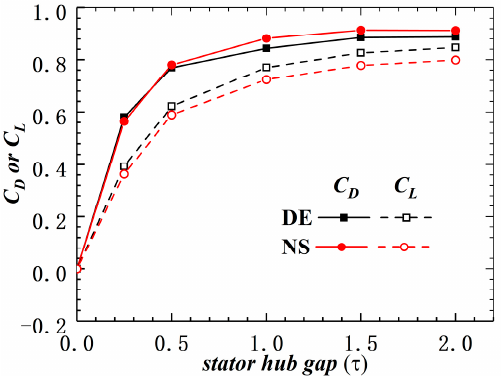
Figure 16. Variation in C D and C L along with the stator hub gap.